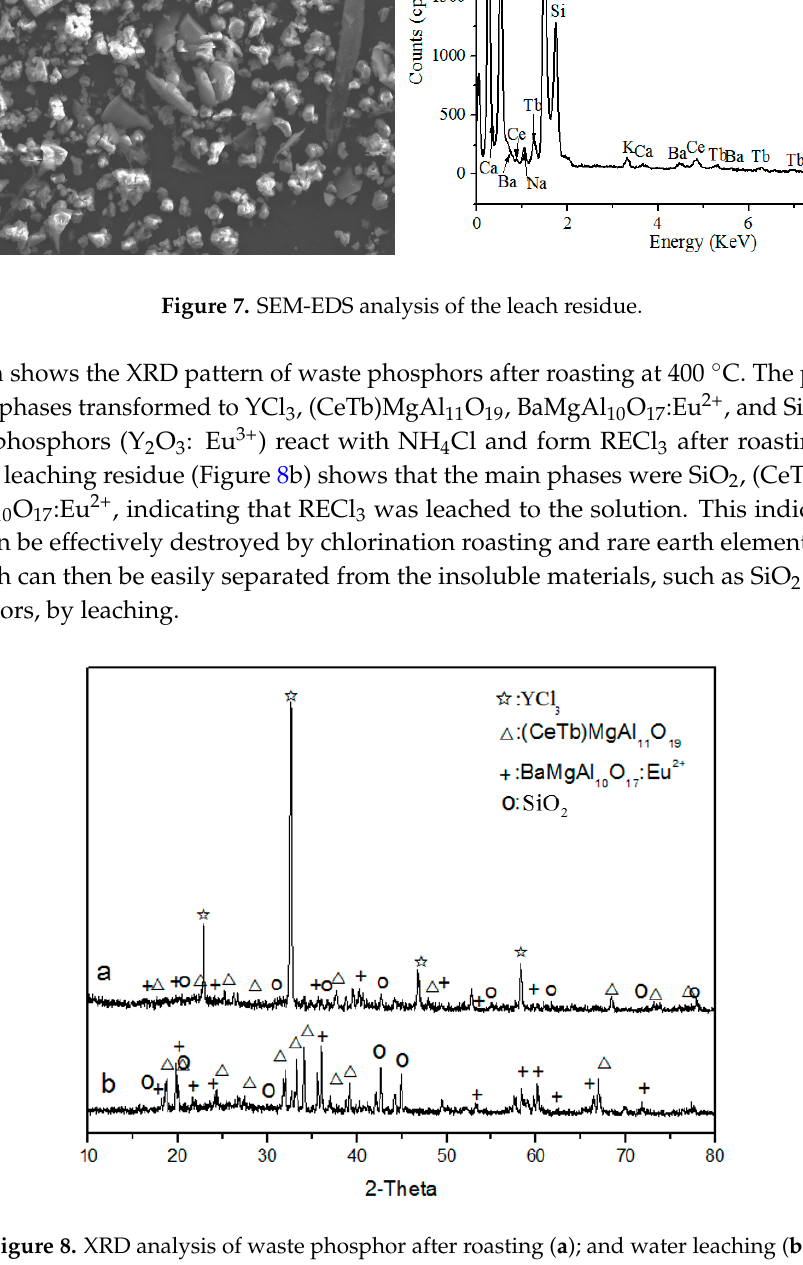
Figure 6. Effect of NH 4 Cl addition on the leaching rate of Y and Eu.